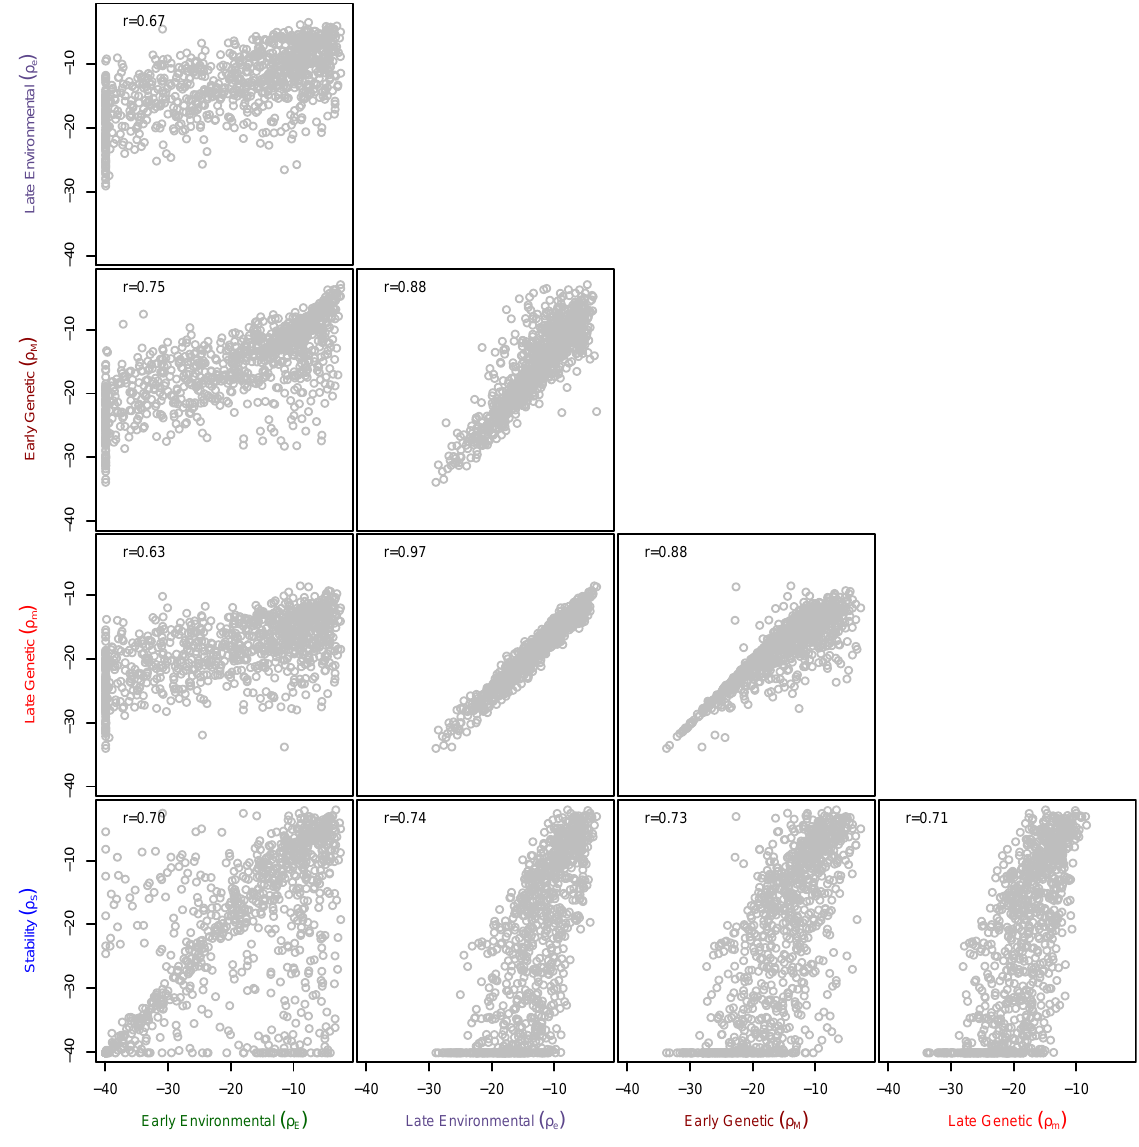
Figure SI2 – Correlations among robustness indexes among random networks. Correla- tions between all five robustness components among 10,000 random 6-gene networks ( µ 0 = 0, σ 0 = 1